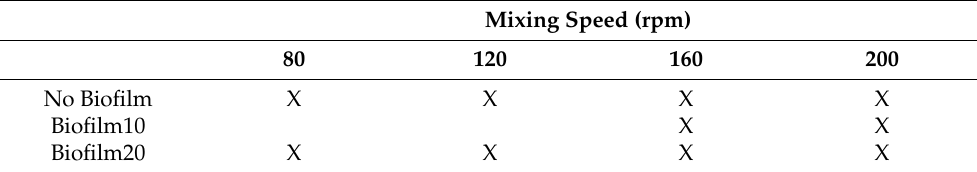
Table 1. Summary of mixing speeds and biofilm ages examined in mixing experiments. Each test was conducted in triplicate. Biofilm10 corresponds to 10-week-old biofilms; Biofilm20 corresponds to 20-week-old